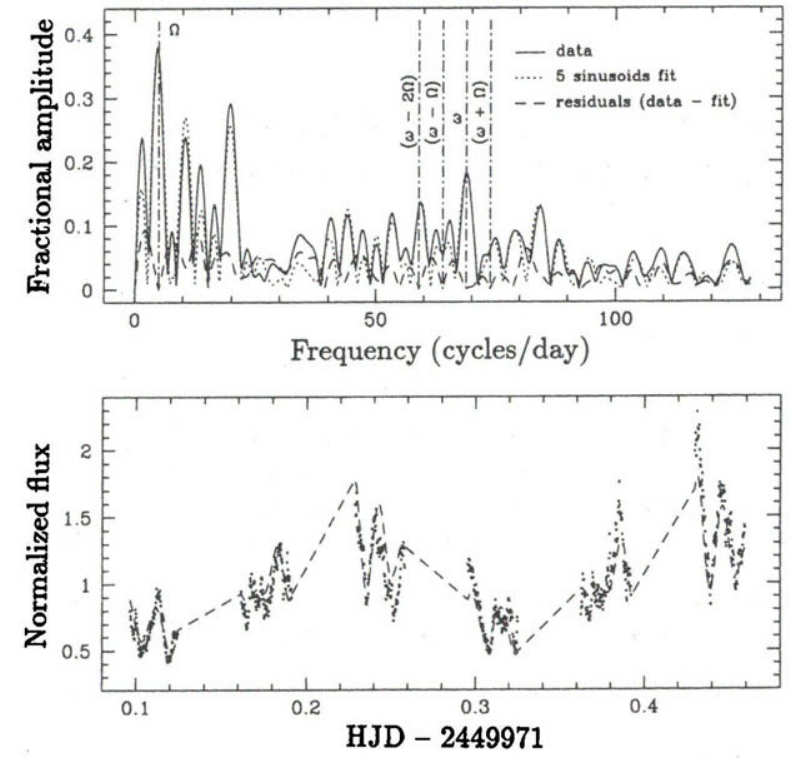
Fig. 1. Total continuum light curve and relative DFT. Note that the two peaks at ~10.3 and 19.7 c/day are artifacts due to the HST orbital period (96 min). Small differences between the exact and the observed orbital frequencies are related to poor sampling of the data (1.8 orbital